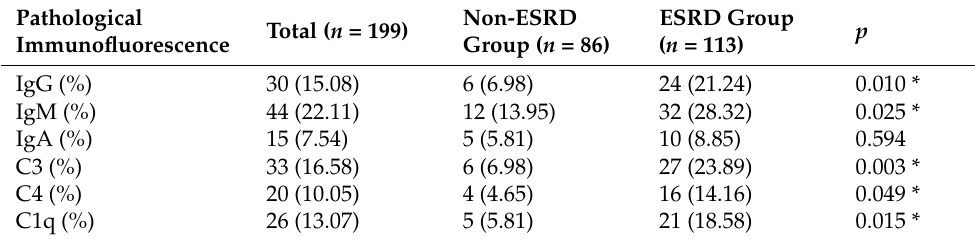
Table 3. Baseline immunofluorescence findings in ESRD and non-ESRD groups.